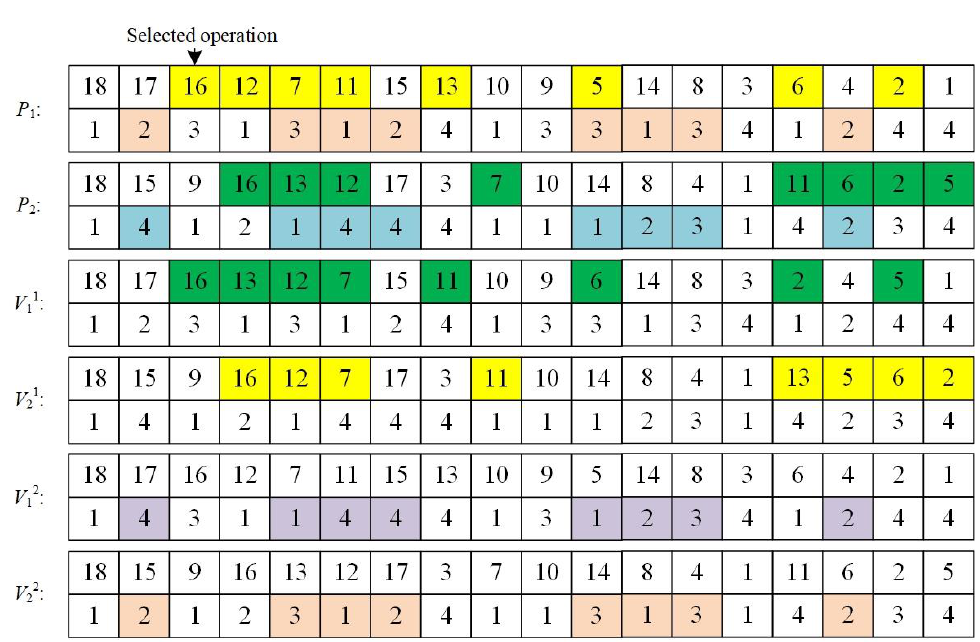
Figure 6. The offspring individuals obtained by applying the above-mentioned subtree-based multi- child crossover method